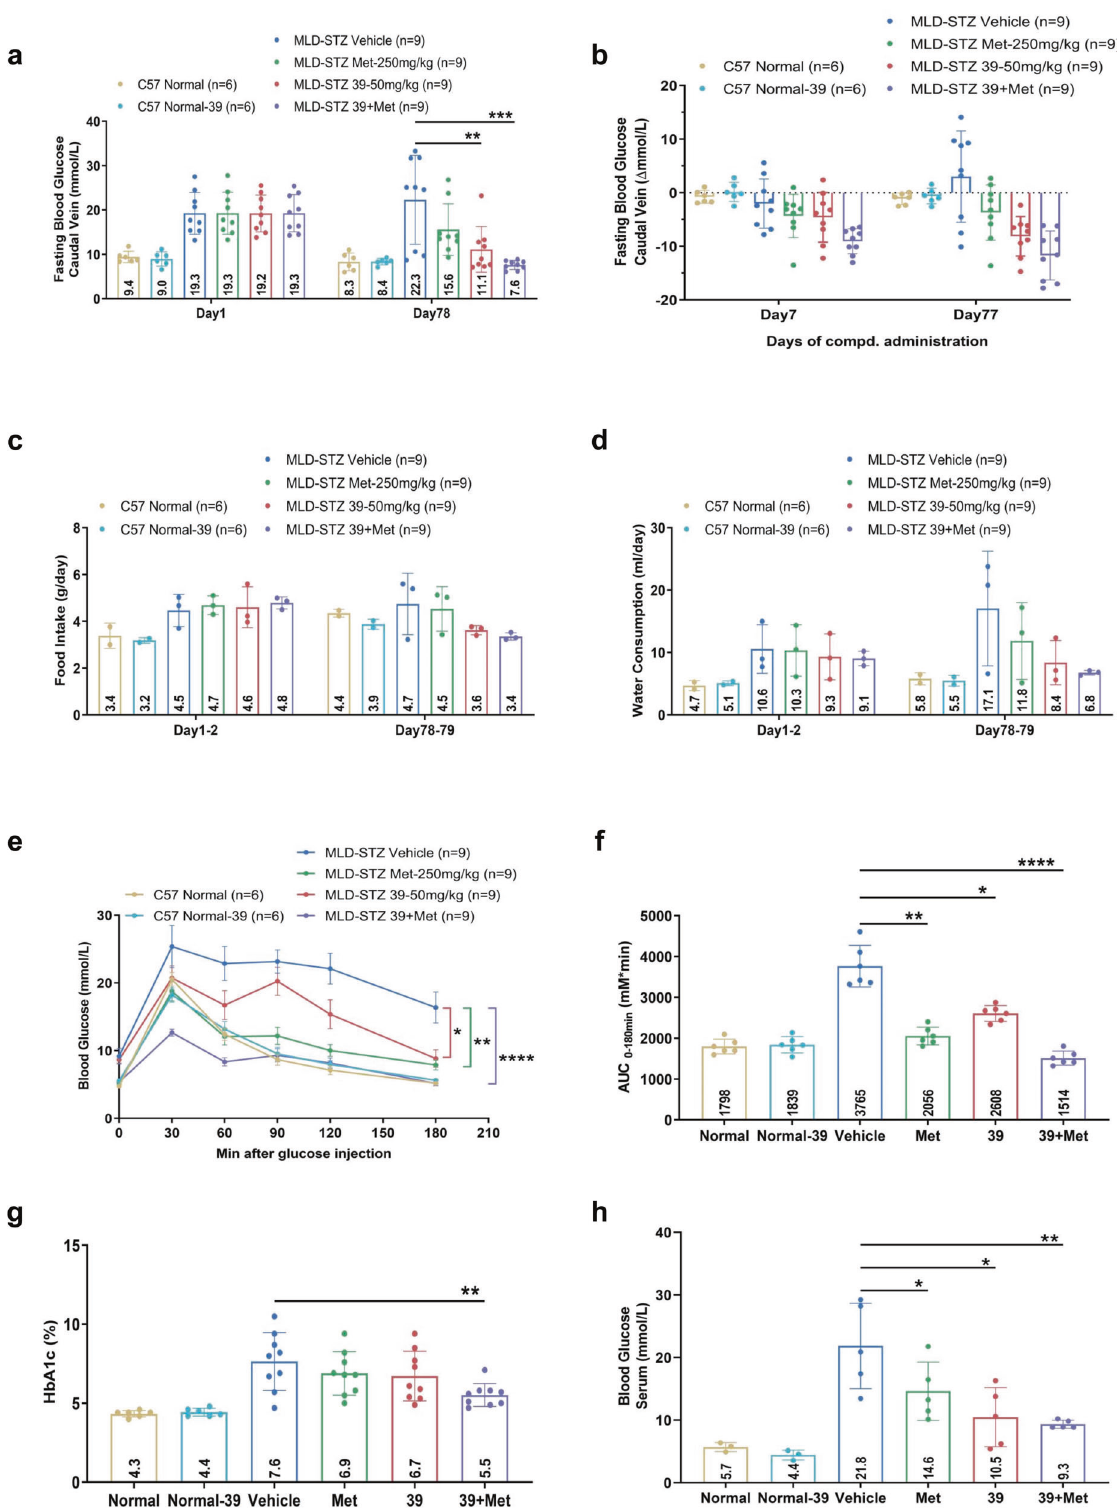
Fig. 3 IHMT-MST1-39 reverses diabetic symptoms in the MLD-STZ mouse model of T1D. a – d Fasting blood glucose (caudal vein), food intake and water consumption measurements for once a week. e – f Intra-peritoneal glucose tolerance test (IPGTT) performed during 0 min and 180 min after glucose injection. Respective area-under-the-curve (AUC) shown in f . g , h HbA1c and blood glucose (serum) level was measured by Chemray-240/800. Data were expressed ±SEM. * p < 0.05, IHMT-MST1-39 compared with vehicle group mice; P values determined by Student ’ s t test